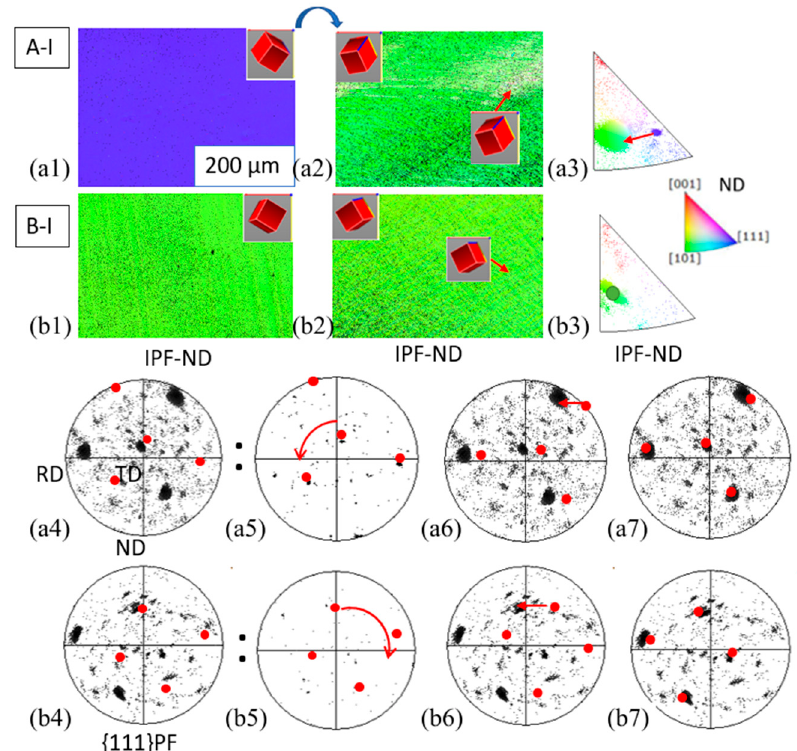
Figure 5. ( a1 – a7 ) and ( b1 – b7 ) are EBSD maps for A-I and B-I, respectively. ( a1 , b1 ) and ( a2 , b2 ) are the EBSD IPF-ND maps for samples before and after the PSC. ( a3 ) and ( b3 ) are the IPF-ND of the undeformed and deformed crystals plotting together, with the arrow indicates the rotation around the loading direction. ( a4 ) and ( b4 ) are the {111}PF for samples after deformation with red dots represents the orientation for the undeformed samples. ( a5 – a7 ) depict the way lattice orientation changes during the deformation: from ( a5 ) to ( a6 ), the red dots rotate dominantly about TD rotation, and from ( a6 ) to ( a7 ), the red dots shift to the left, indicating a further RD rotation. The same logic of analyzing applies to ( b5 – b7 ).